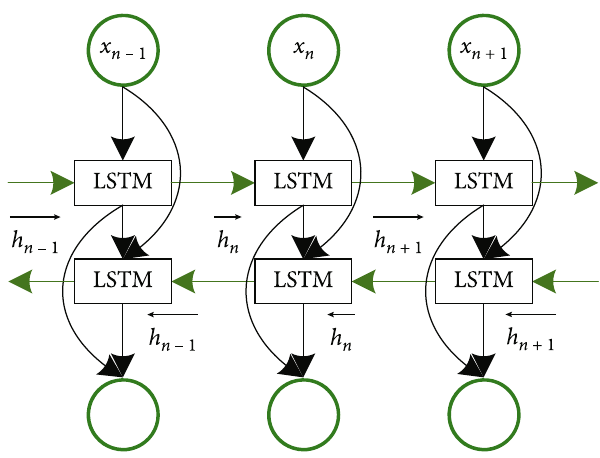
Figure 2: The net structure of